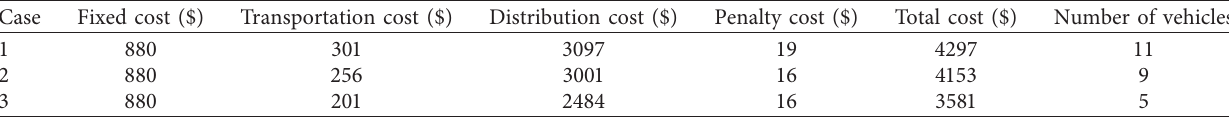
Table 8: Comparison among different vehicle-sharing scenarios.